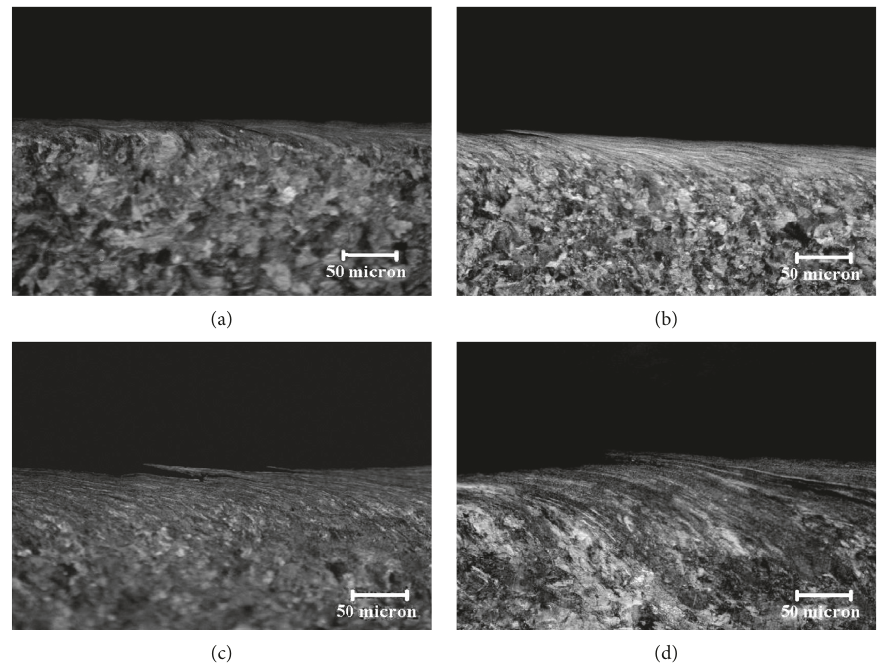
Figure 2: Plastic flow deformation of different rail samples: (a) quenched PD3 rail (200 × ); (b) hot-rolled PD3 rail (200 × ); (c) quenched U71Mn rail (200 × ); (d) hot-rolled U71Mn rail (200 × ).